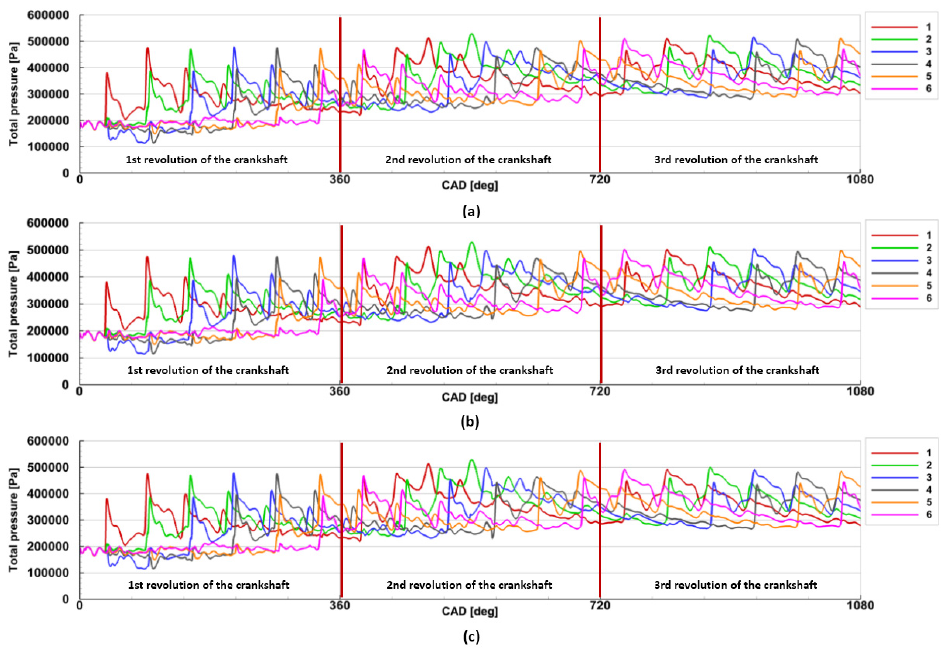
Figure 8. The plot of the total pressure at the 1-st stage turbine inlet for the 30° VTG opening at: ( a ) 60,000 rpm , ( b ) 50,000 rpm , ( c ) 40,000 rpm turbine speed.